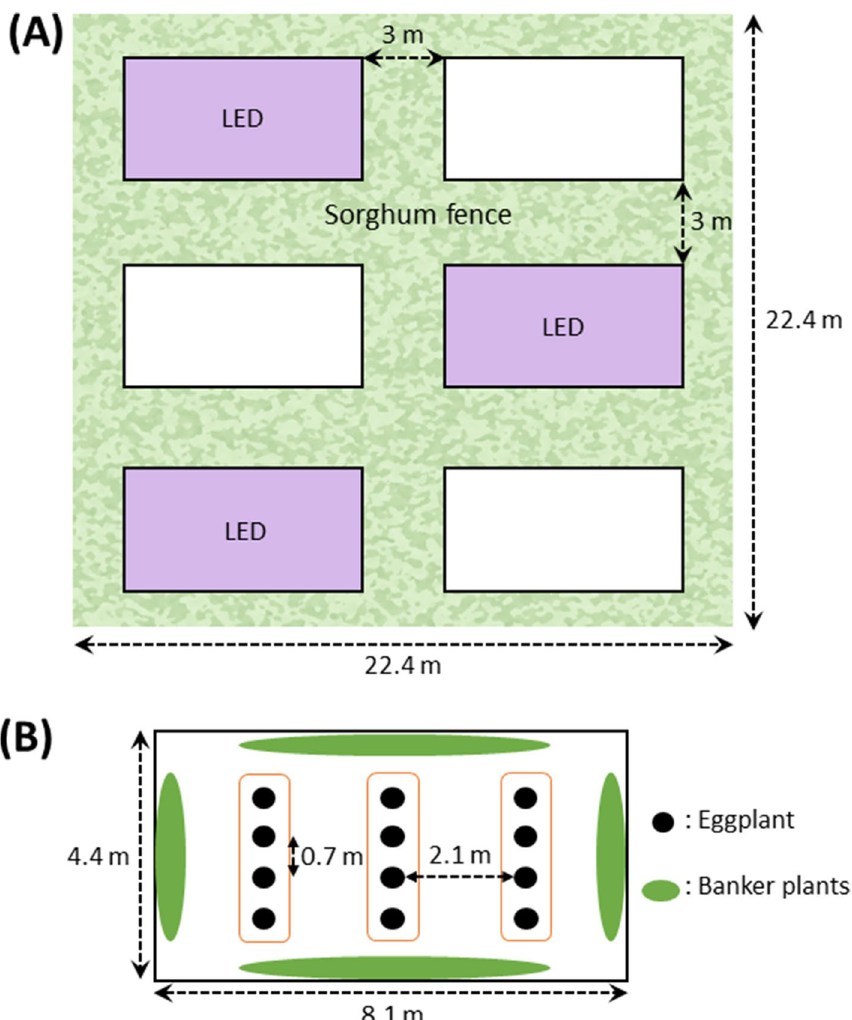
Figure 1. Plot design and locations of experimental plots in the eggplant field. ( A ) The experimental field had six plots which included three illuminated plots and three non-illuminated plots. Sorghum fence approximately 3 m in width were planted to separate each experimental plot to minimize inter-plot interference. ( B ) There were three rows of eggplant per plot. Four eggplant trees were planted in a row. Banker plants were planted surrounding eggplant rows. Space between eggplants was 0.9 m in the row, and one plot consisted of three rows 2.5 m